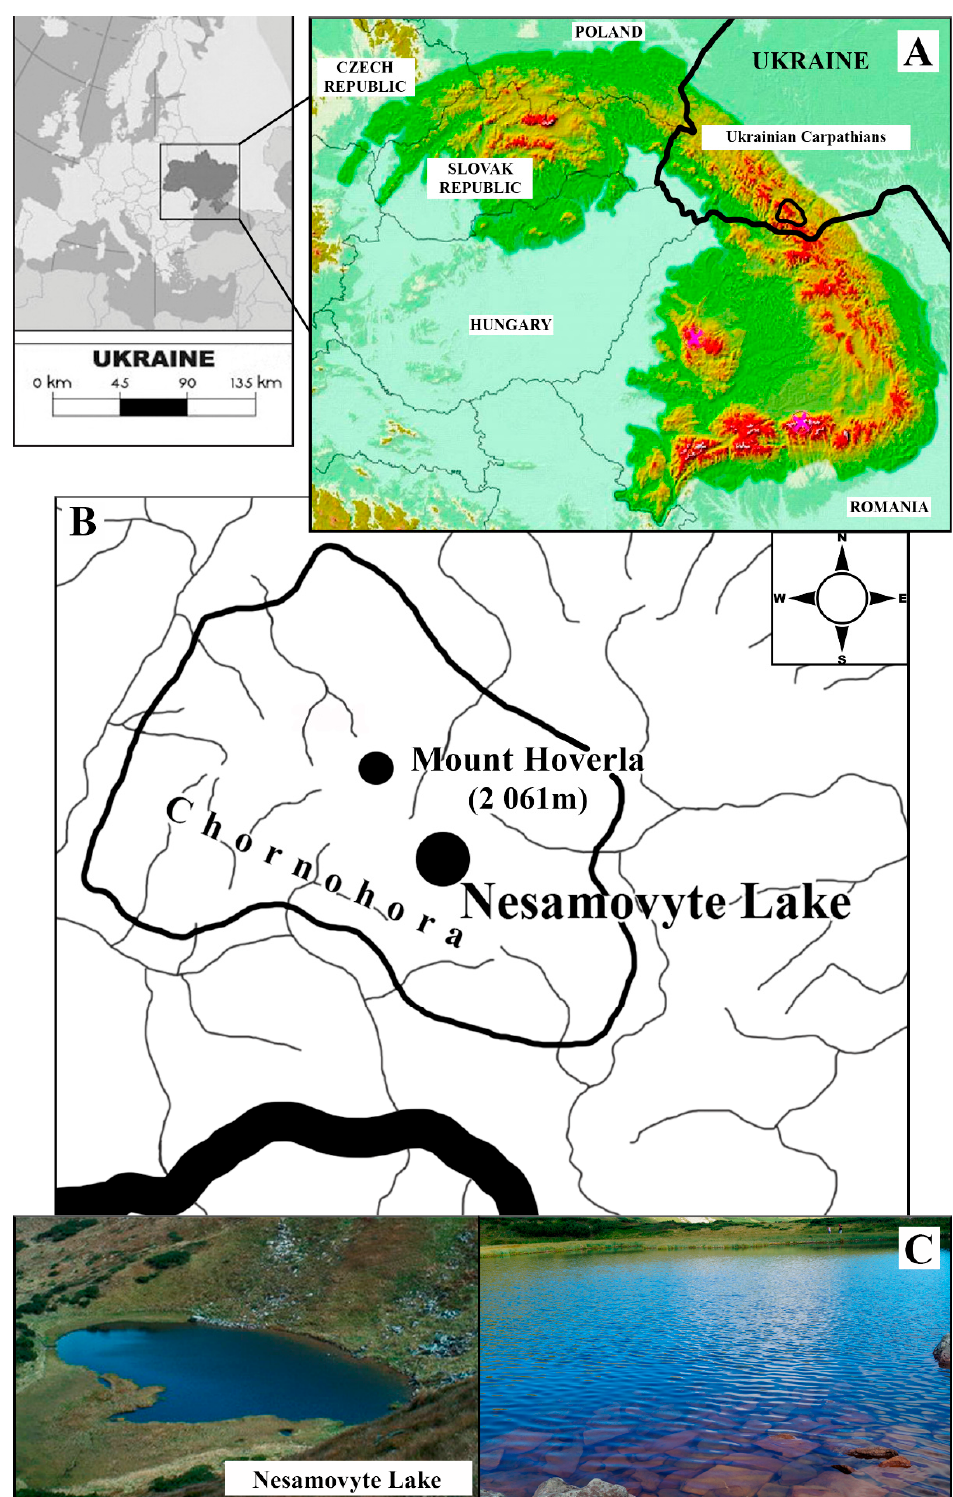
Figure 1. Map of the Carpathian region and the location of the Nesamovyte Lake. ( A )—the Carpathian Mountains with its Eastern part the Ukrainian Carpathians. ( B )—map-scheme of Chornohora Massif with the location of the lake. ( C )—littoral zone of the lake. The lake covers an area of about 0.4 hectares (about 88 × 45 m) and has a depth of about 2 m and, according to the EC Water Framework Directive [29], belongs to